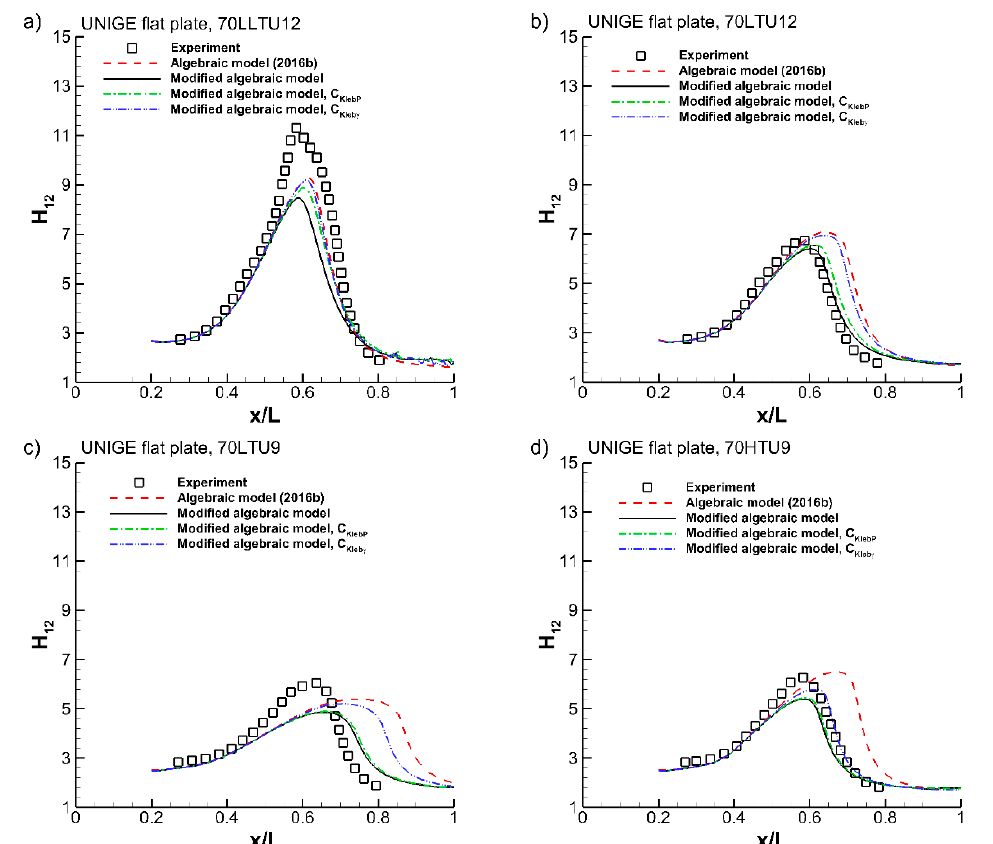
Figure 6. UNIGE flat plate. Measured and predicted shape factor evolutions for cases with transition in a separated boundary layer influenced by free-stream turbulence. Strong adverse pressure gradient ( a , b ) and moderate gradient ( c , d ).